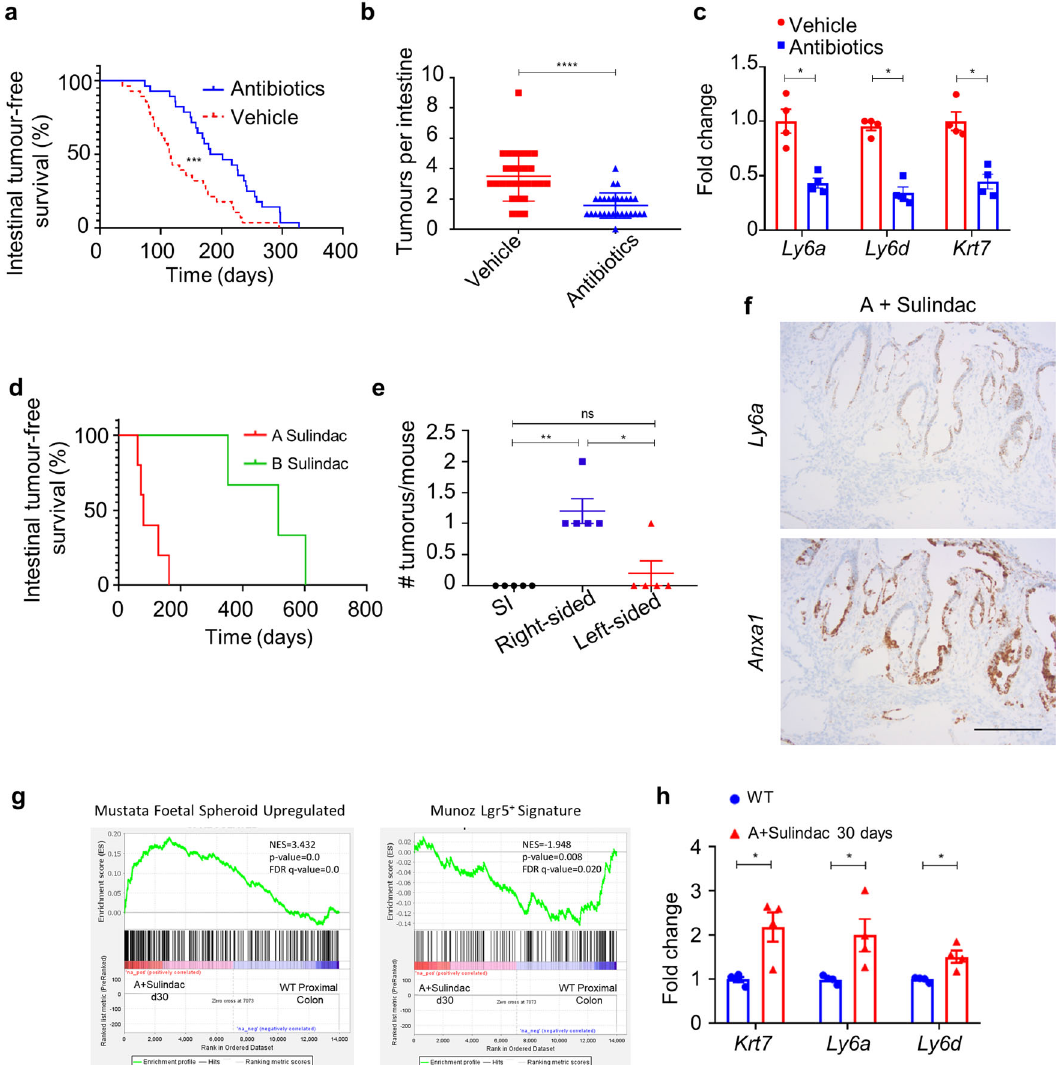
tumour-free survival (days after tamoxifen-induction) of vehicle-treated ( n = 28) and antibiotic-treated ( n = 28) BA mice (*** p = 0.0006; Mantel-Cox log- rank test, two-tailed). b Total number of intestinal tumours in vehicle-treated ( n = 28) and antibiotic-treated ( n = 28) BA mice. Mean ± s.e.m. (**** p = 2.9e